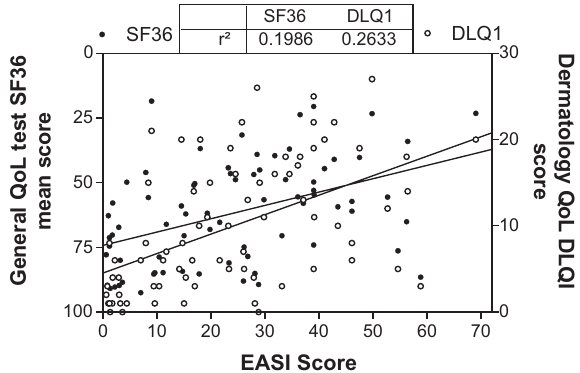
Figure 1 - Distribution of mean scores of Quality of life tests according to disease severity (EASI) in AD adult patients in Brazil. Closed circles: mean value of SF36 domains Open circles DLQI scores. Line shows linear regression of each QoL test. Tables shows correlation between tests and disease severity, both with